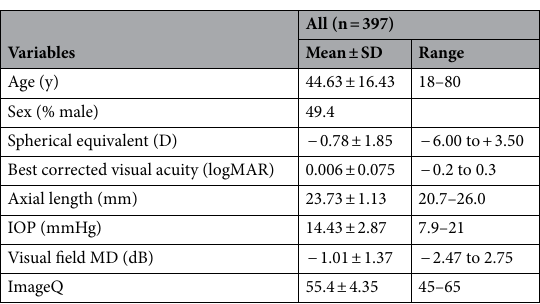
Table 1. Demographic characteristics and ocular features of the study participants (n =